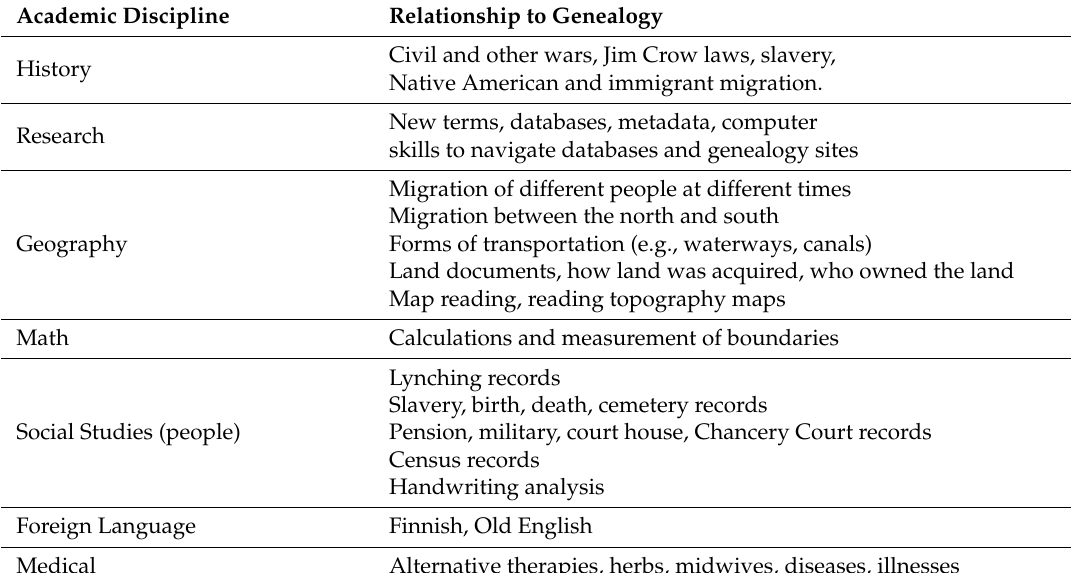
Table 2. Different academic subjects that participants in this study felt they needed to acquire more